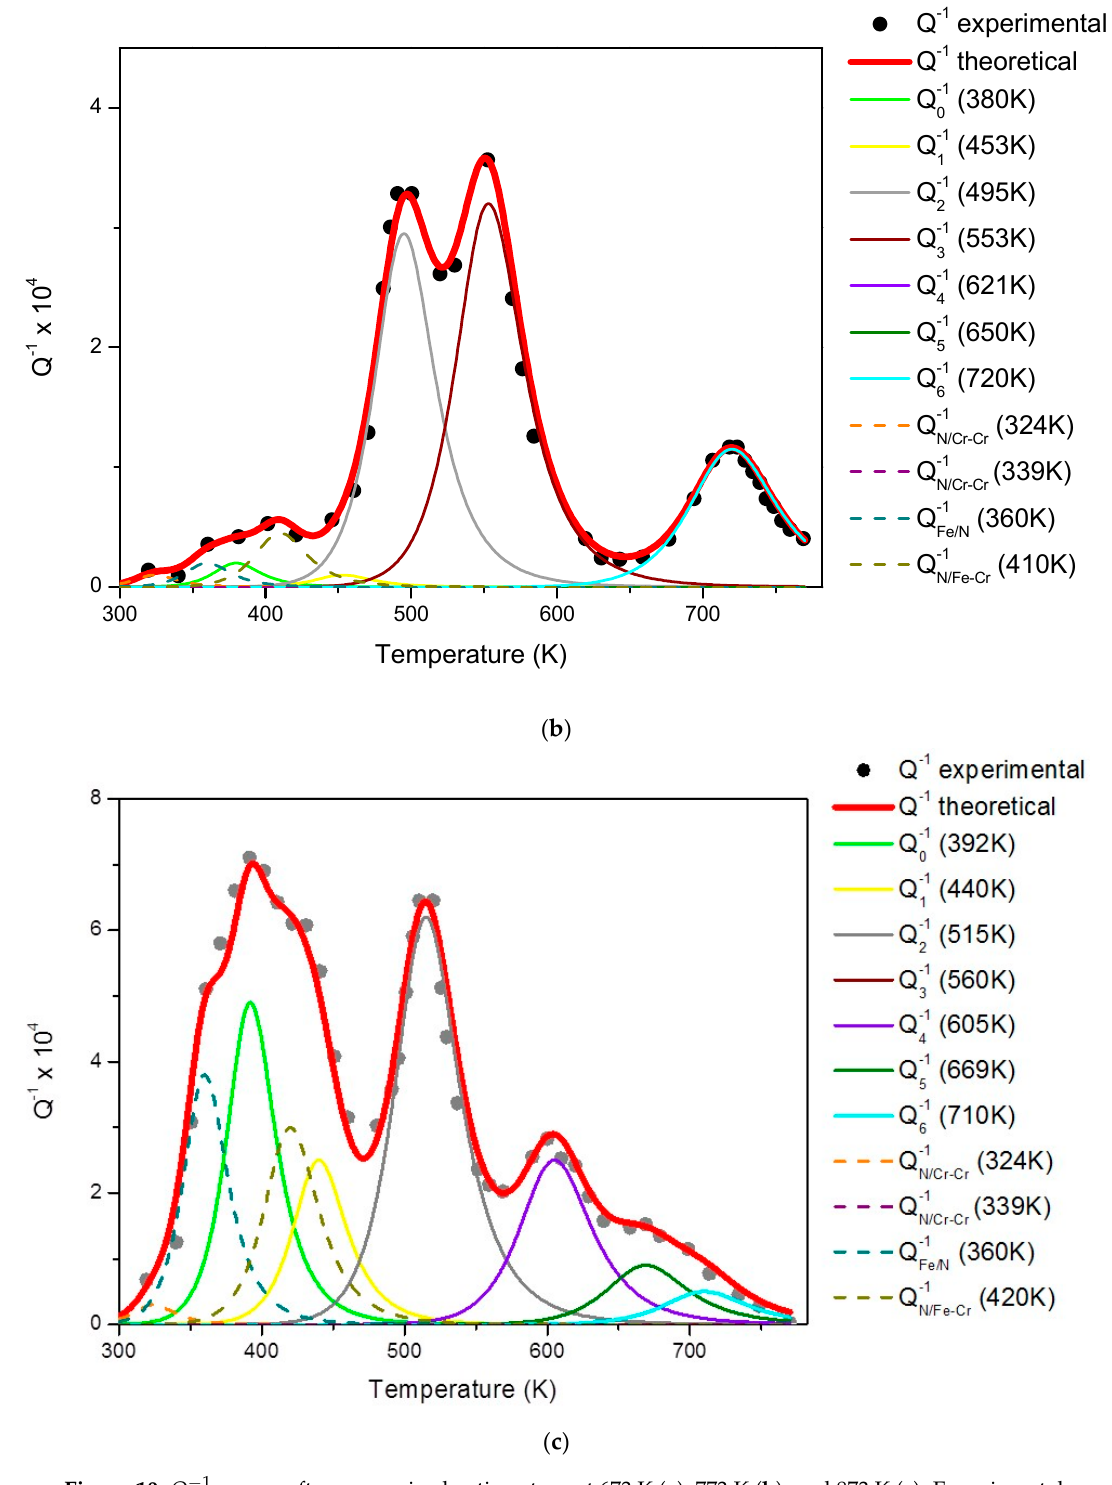
Figure 10. Q − 1 curves after successive heating steps at 673 K ( a ), 773 K ( b ), and 873 K ( c ). Experimental data are reported after background subtraction.